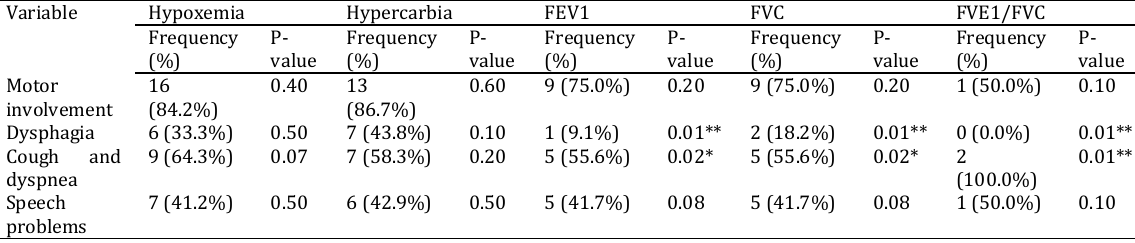
Table 3. Relationship between disease symptoms and study variables